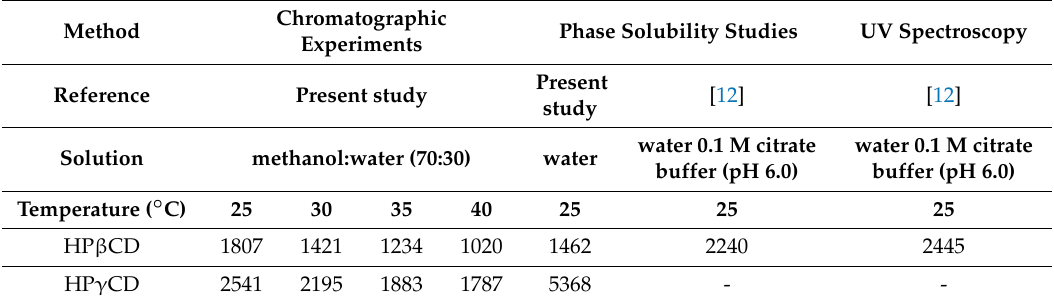
Figure 4. Plots of 1/ k vs. [HPβCD] ( ) or [HPγCD] ( ) (assuming 1:1 stoichiometry) for dexamethasone acetate at a column temperature equal to 40 °C. Stationary phase: phenyl silica gel; mobile phase: mixture methanol: water (70:30 v / v ). Table 4. Apparent association constants K of the complexes DXMa/HPβCD and DXMa/HPγCD determined by chromatographic procedure at various temperatures compared to literature data.